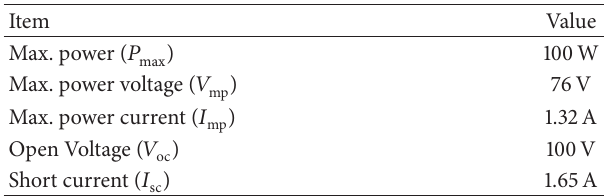
Table 1: CSSS-100 solar array specifications.